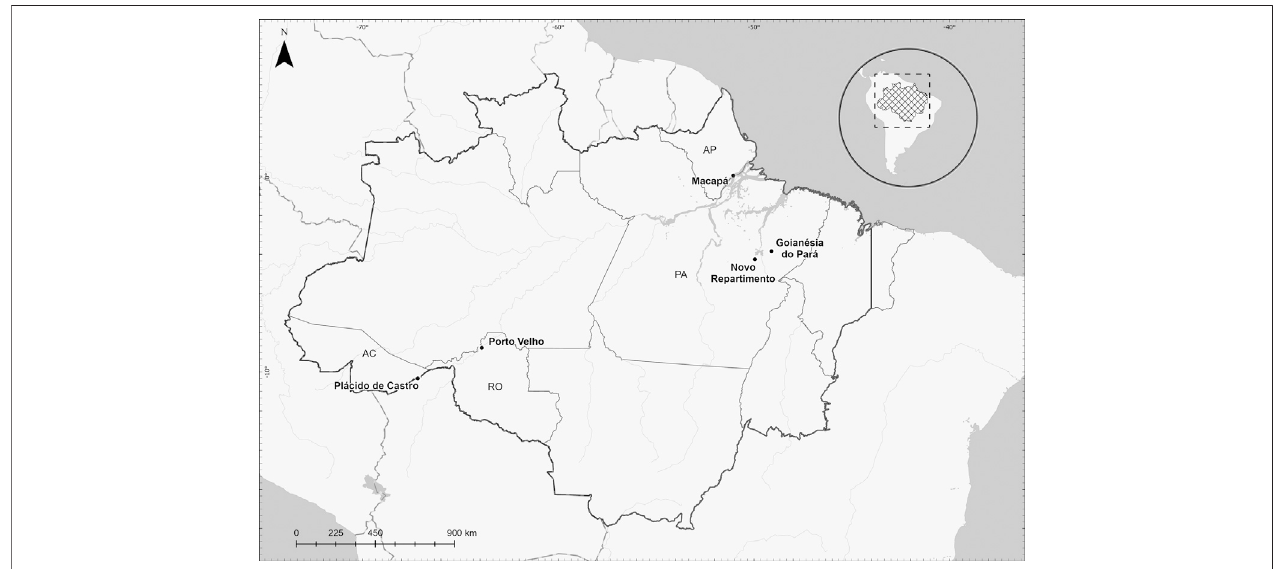
FIGURE 1 | Study area of the CYP 2D6 genotyping in the Amazon region of Brazil. Plácido de Castro/Acre State – AC (10 ° 16 ′ 33 ″ S; 67 ° 09 ′ 00 ″ O) is located at the border of Rond ˆ onia and Amazonas states, it has a population of 18,235 inhabitants; Porto Velho/Rond ˆ onia State - RO (08 ° 45 ′ 43 ″ S; 63 ° 54 ′ 14 ″ O) is the capital of the State of Rond ˆ onia in the upper Amazon River basin, with 383,425 inhabitants; Novo Repartimento/Pará State – PA (04 ° 19 ′ 50 ″ S; 49 ° 47 ′ 47 ″ O) is a gold mining area in southeastern ParáState.Its populationoscillatesand isestimated ataround55,759habitants; Macapá/Amapá State-AP(00 ° 02 ′ 20 ″ S;51 ° 03 ′ 59 ″ O) isthecapital ofthe state ofAmapá and islocated bythe margins ofthe Amazon River. Its estimated population is366,486 inhabitants. (Cavasini et al., 2007).and Goianésiado Pará/ Pará State – PA (03 ° 50 ′ 33 ″ S; 49 ° 05 ′ 49 ″ O), located in the southeastern region of the State of Pará in the north of Brazil. Its population is estimated as 28,583 habitants (Cassiano et al., 2015). The climate in these areas is characterized as tropical with no dry season; the mean monthly precipitation level is at least 60 mm. The samples were recruited at the respective Malaria Diagnosis Centers.